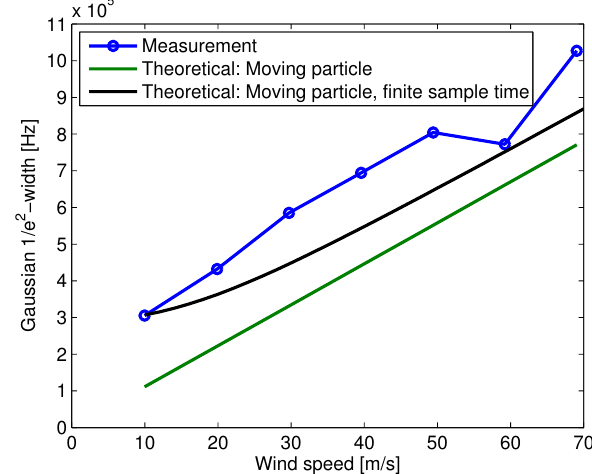
Fig. 9. Spectral bandwidth as function of wind speed. The measured values are represented by the dots, while the green and black curves indicate the theoretical